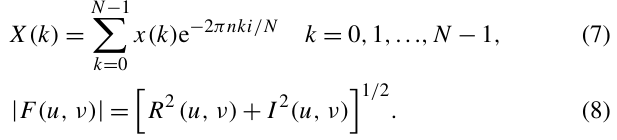
White noise is a random signal with a mean value of 0. Based